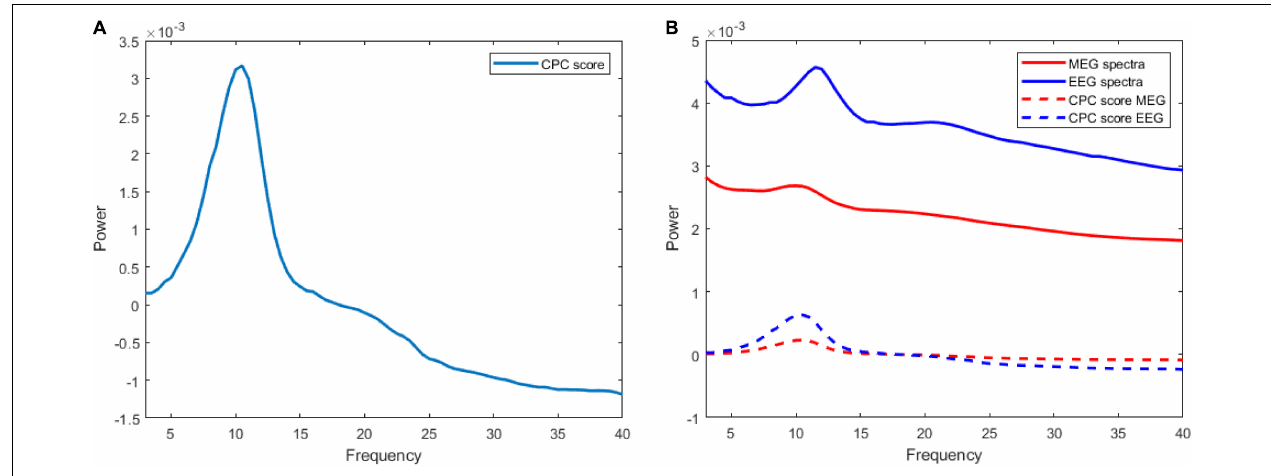
FIGURE 3 | (A) Curve representing common source topography Q computed via stepwise-CFCPC with scale value ( λ ) 0.0072735 for MEG and 0.19906 for EEG. Frequency is on the x-axis, and the y-axis represents the power scale. (B) Comparison of actual MEG and EEG source spectra with their CPC-scored versions.